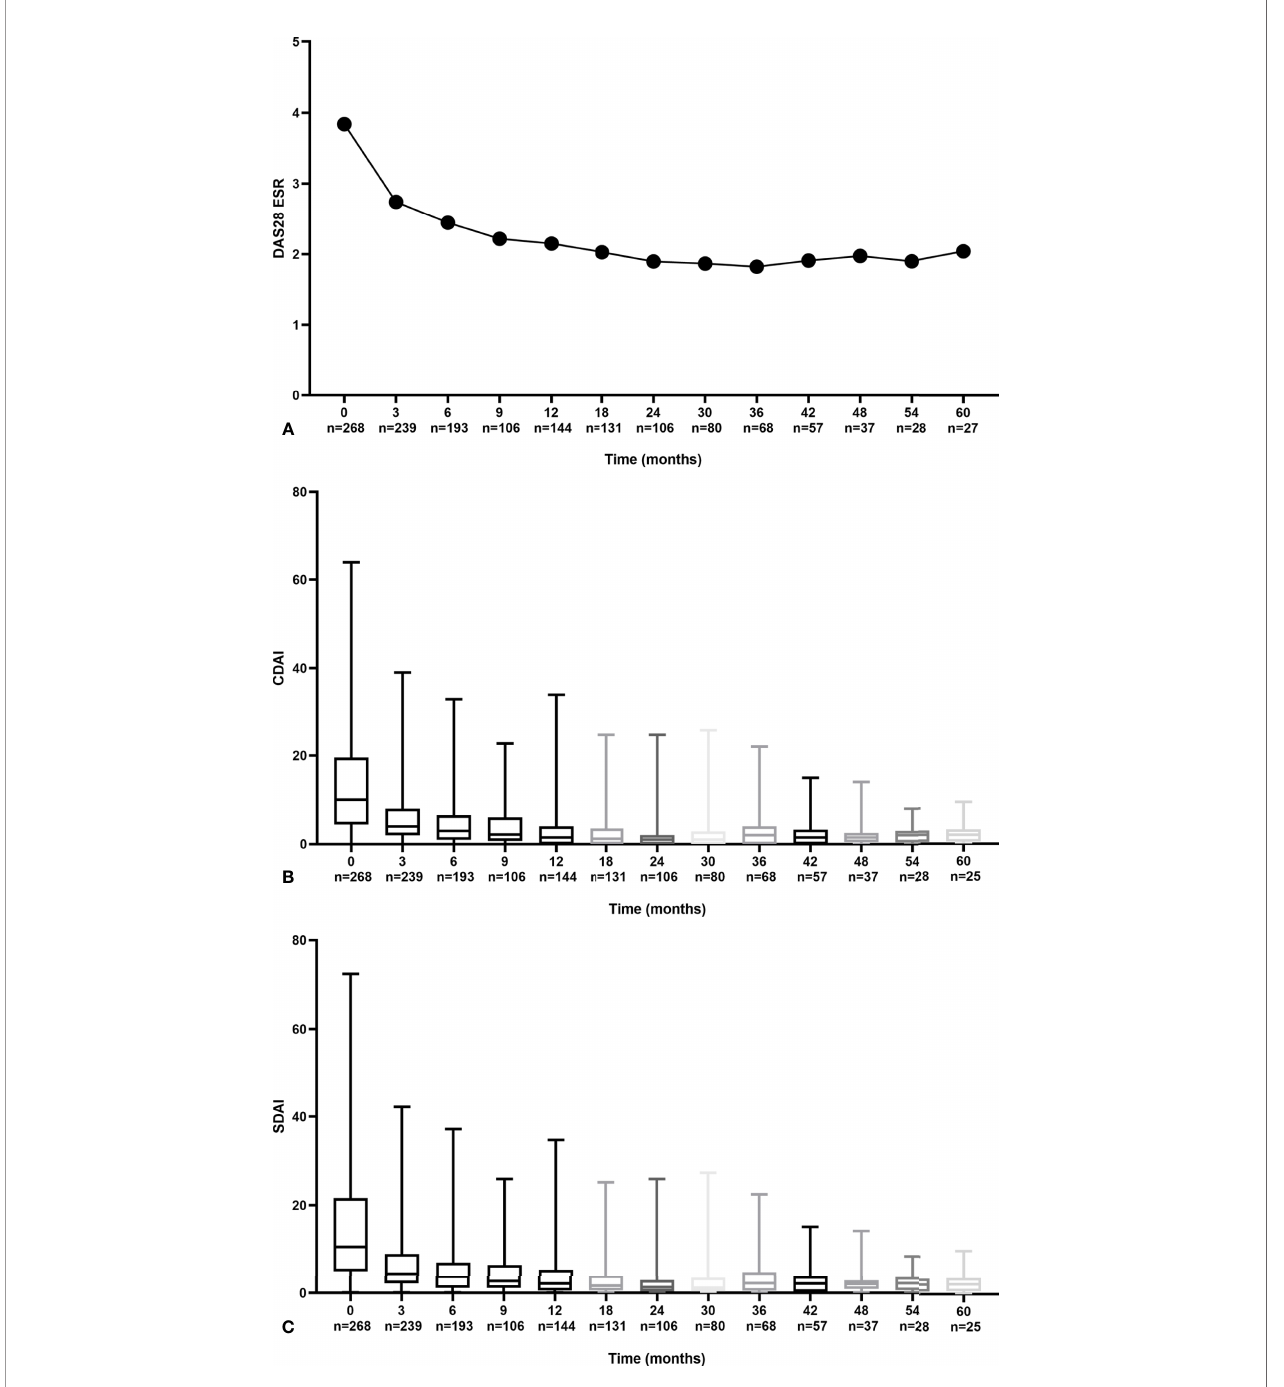
FIGURE 1 | Trends in disease activity scores during follow-up by DAS28 (A) CDAI (B) and SDAI (C)